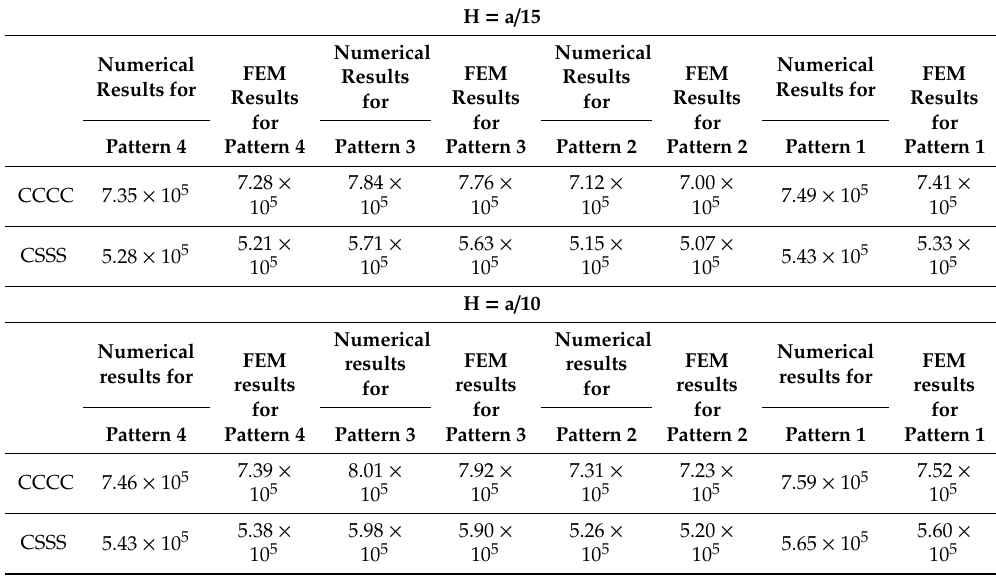
Table 5. Validation of numerical results with finite element outcomes (b / a = 5, h = a / 10, R 1 = 6a, R 2 = 2a, ∆ T = 20 K , g = 1%, and N = 5). GPL L